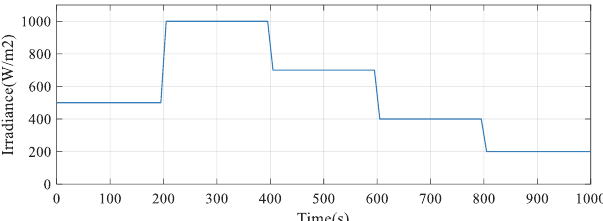
Figure 12. Fluctuation of light intensity in Example 1.